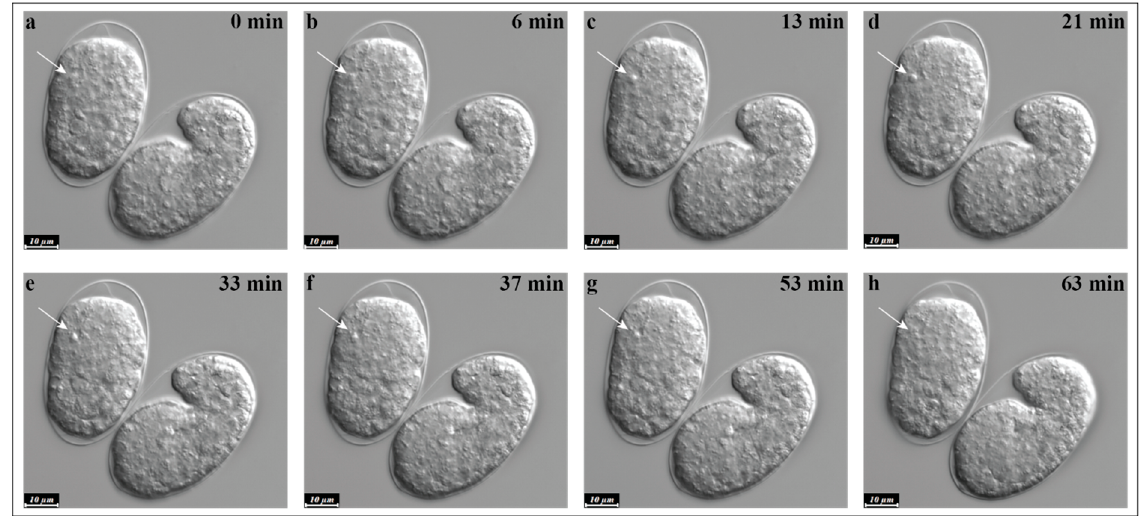
Figure 2. Apoptosis in C. elegans embryo. Different stages of developmental apoptosis in C. elegans embryo. ( a ) Pre-apoptotic cell; ( b ) apoptosis initiation; ( c ) initiation of engulfment; ( d – f ) engulfment; ( g , h ) disappearance. Relative time is indicated at the upper right of each frame; Arrow indicates the dying cell at different stages. Scale bar: 10 µ m. For the experimental procedure, see the Materials and Methods